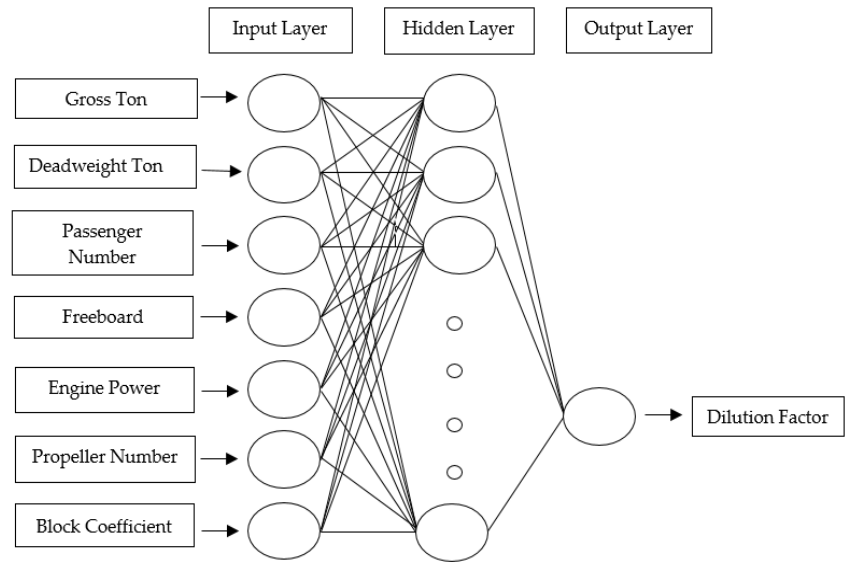
Figure 1. The ANN model.